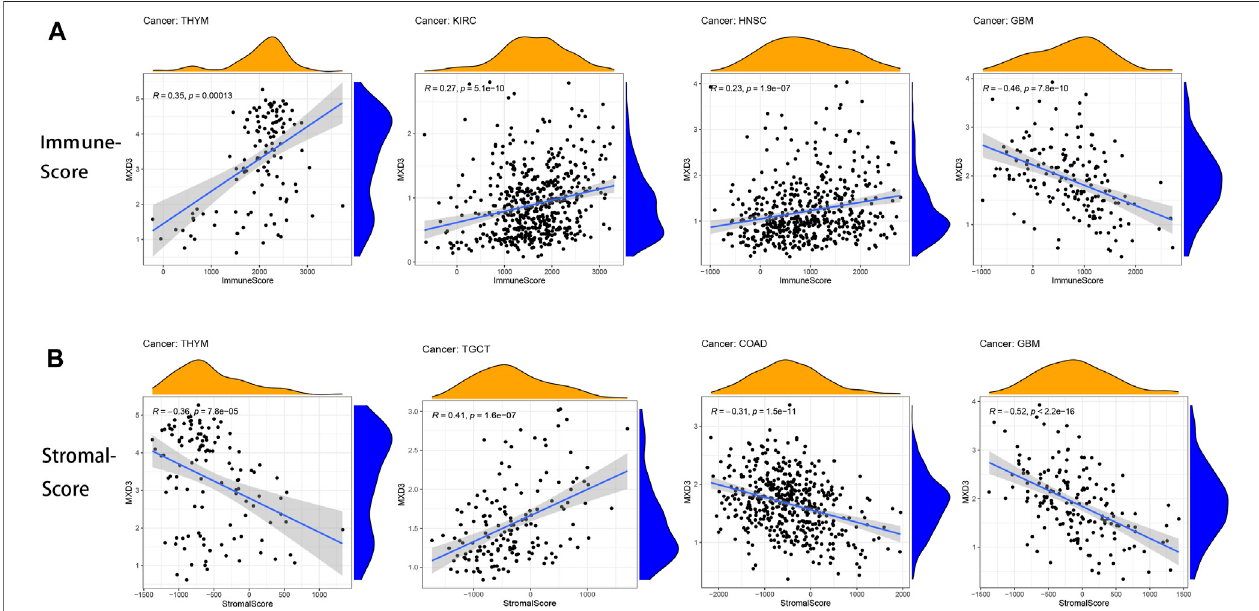
FIGURE 10 | (A) The four cancers with the highest correlation between the immune score and MXD3 expression. (B) The four cancers with the highest correlation between the stromal score and MXD3